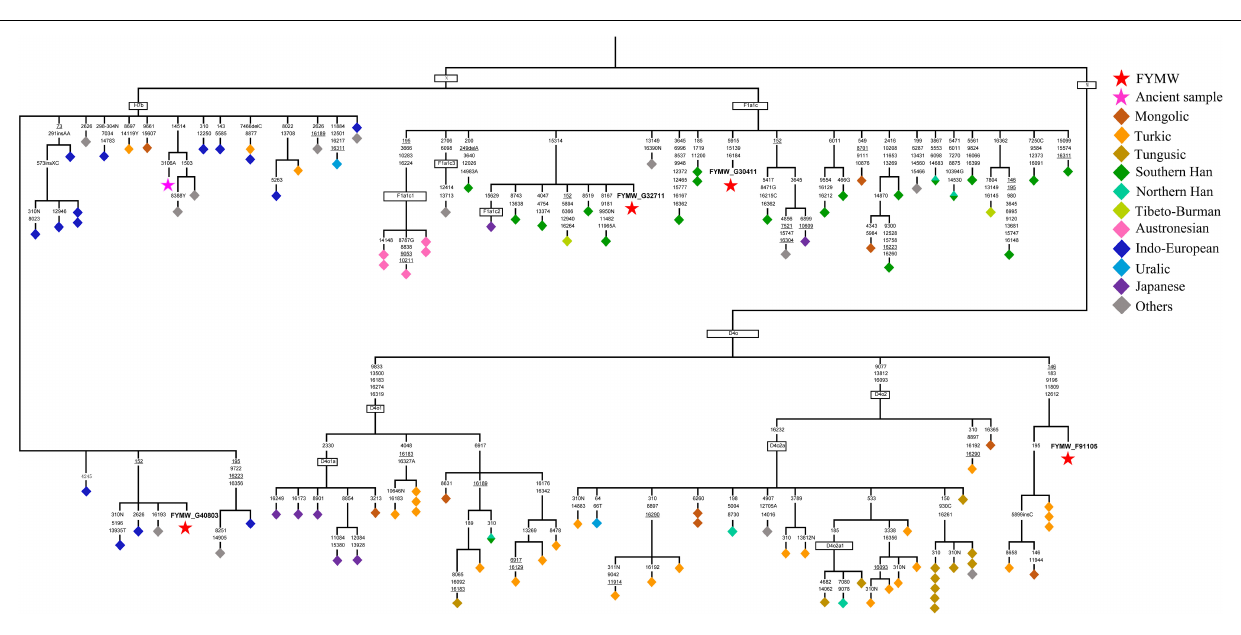
three representative haplogroups (i.e., D4o, F1a1c, and H7b ∗